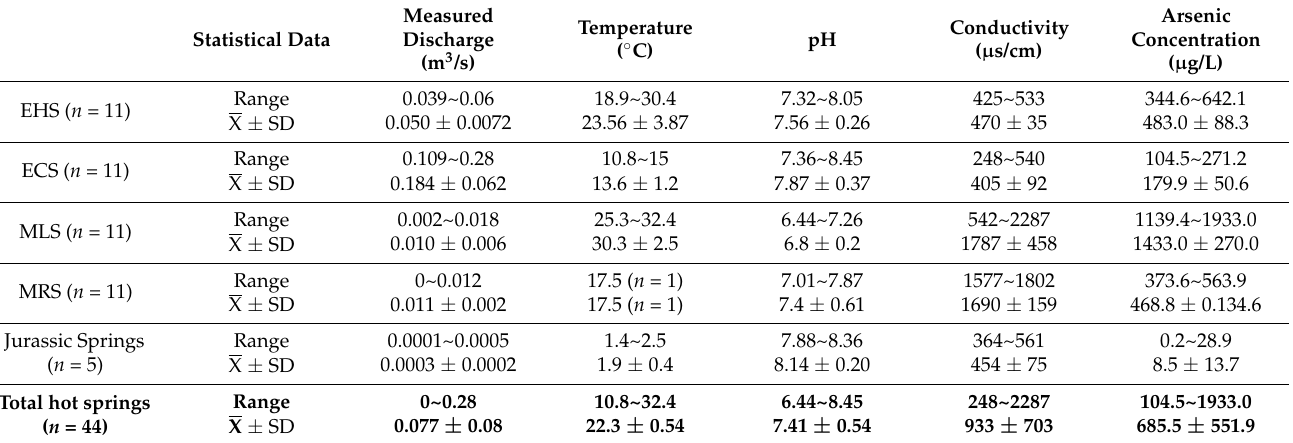
Table 2. Monitoring results of springs in the study